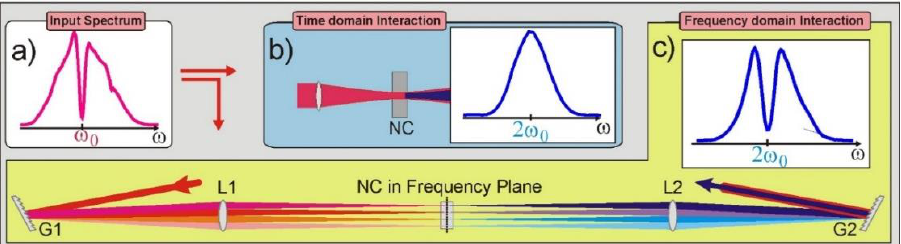
Fig. 1: A shaped input spectrum (a) is frequency doubled either in (b) conventional time domain nonlinear optics (TNO) or (c) via Frequency domain nonlinear optics (FNO). The convolution of different frequencies in TNO (b) leads to a smoothening of the input function while in FNO the shape is preserved since the mutual frequency crosstalk is turned off. This decoupling permits a transfer of arbitrary phase functions. NC: nonlinear